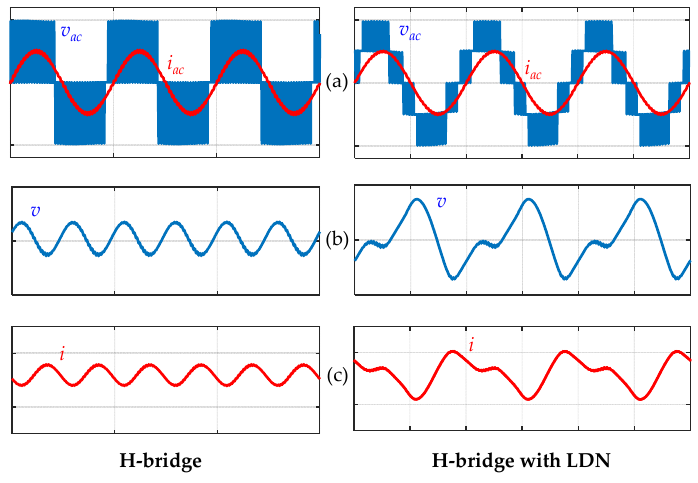
Figure 10. Simulation examples of: ( a ) grid current and inverter output voltage; ( b ) PV voltage; and ( c ) PV current, in case of H-bridge without LDN (left column), and in case of H-bridge with LDN (right column).